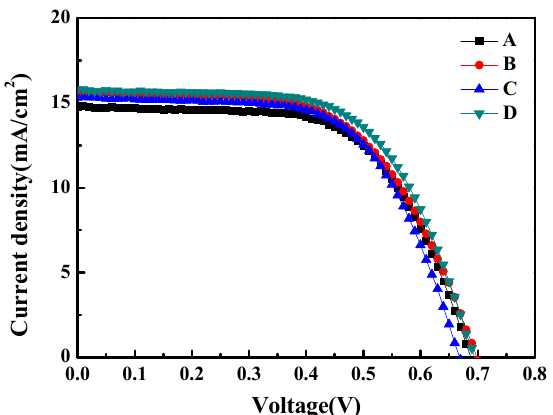
Figure 6. Current density (J) versus voltage (V) characteristics of the DSSCs. Curves from A to D represent the J-V curve of bare glass ( sample A ), PDMS/glass ( sample B ), flat PMMA/PDMS/glass ( sample C ) and subwavelength moth-eye structured PMMA/PDMS/glass ( sample D ), respectively.